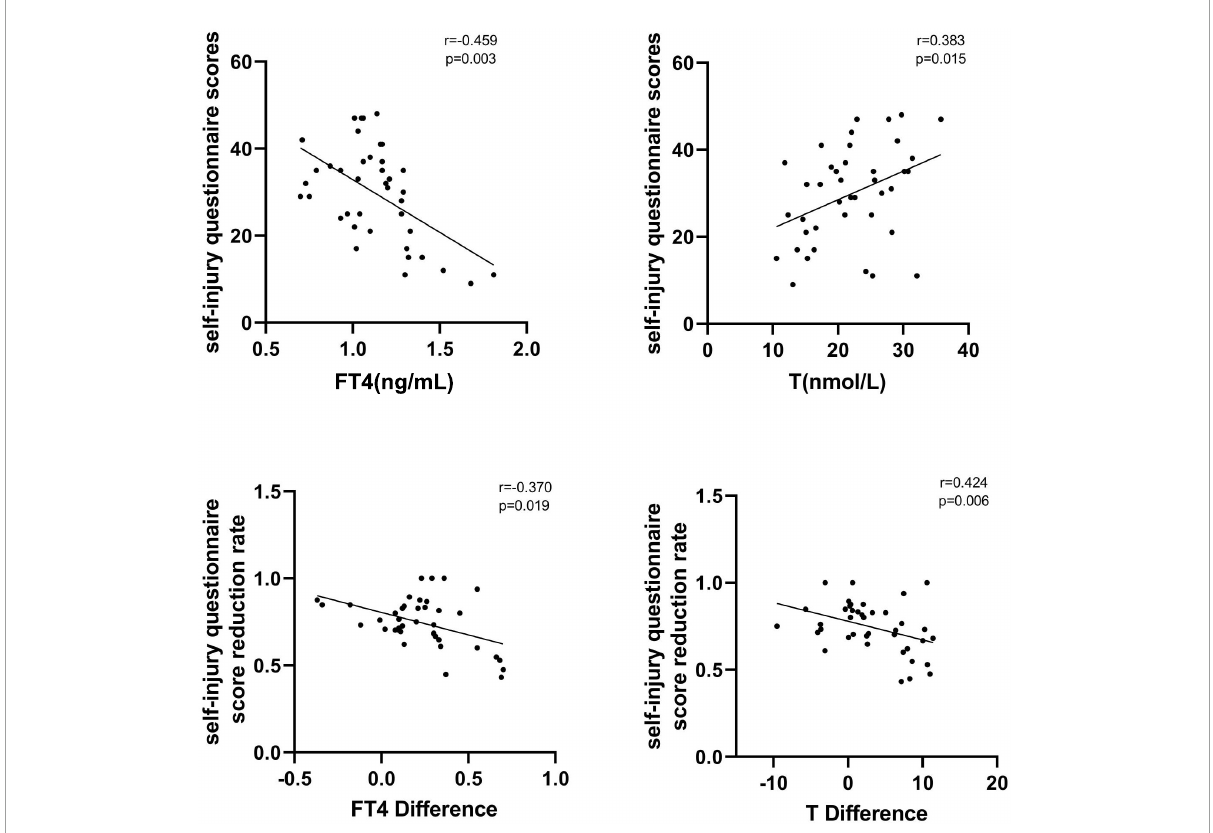
FIGURE1 Correlation between hormone levels and self-injury questionnaire scores.